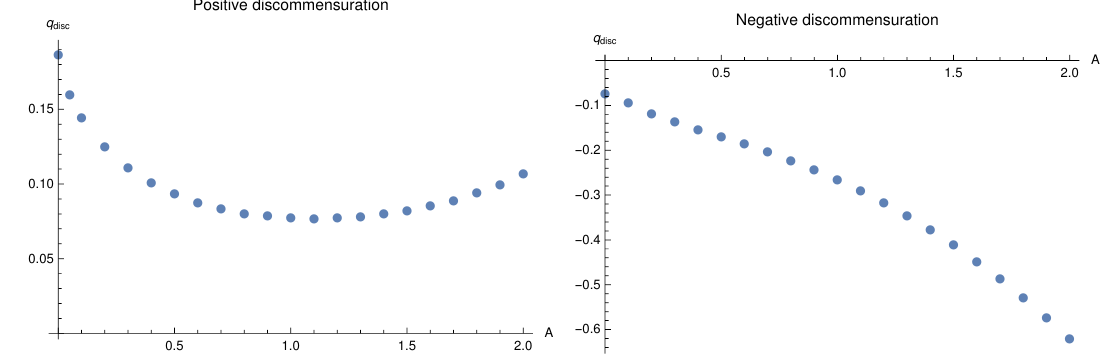
Figure 6 . Charge of a single discommensuration measured with respect to the \parent" commen- surate state, depending on the amplitude of the lattice. There are no preferred values, as opposed to the naive expectations.